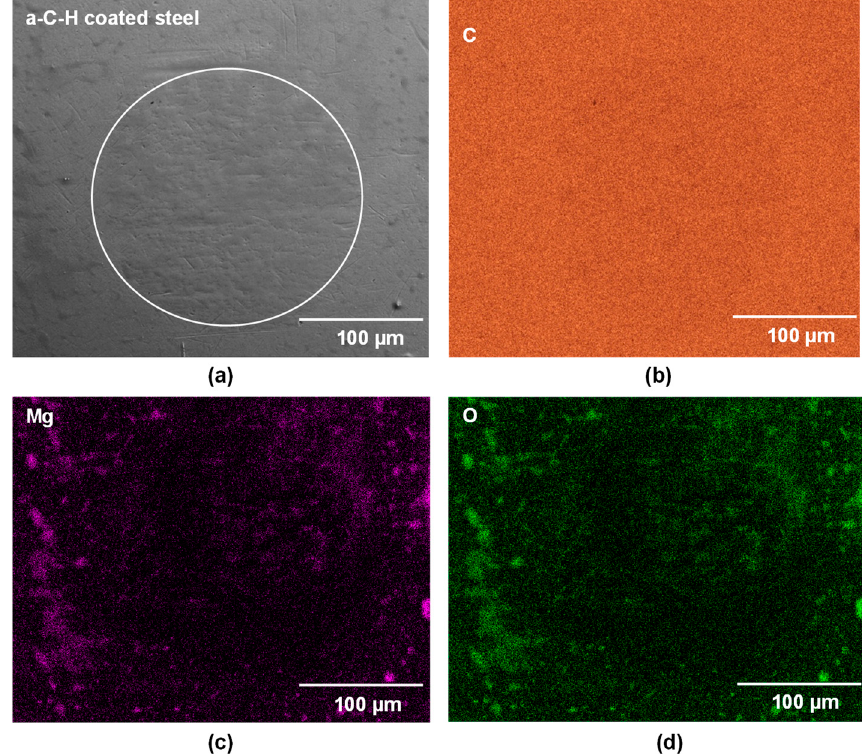
Figure 7. ( a ) Secondary electron image of a-C-H coated 52100 steel ball surfaces tested against the PEO-coated AZ31 at 200 ° C. The EDS maps of the whole contact area in ( a ) are presented for ( b ) C, ( c ) Mg, and ( d ) O.